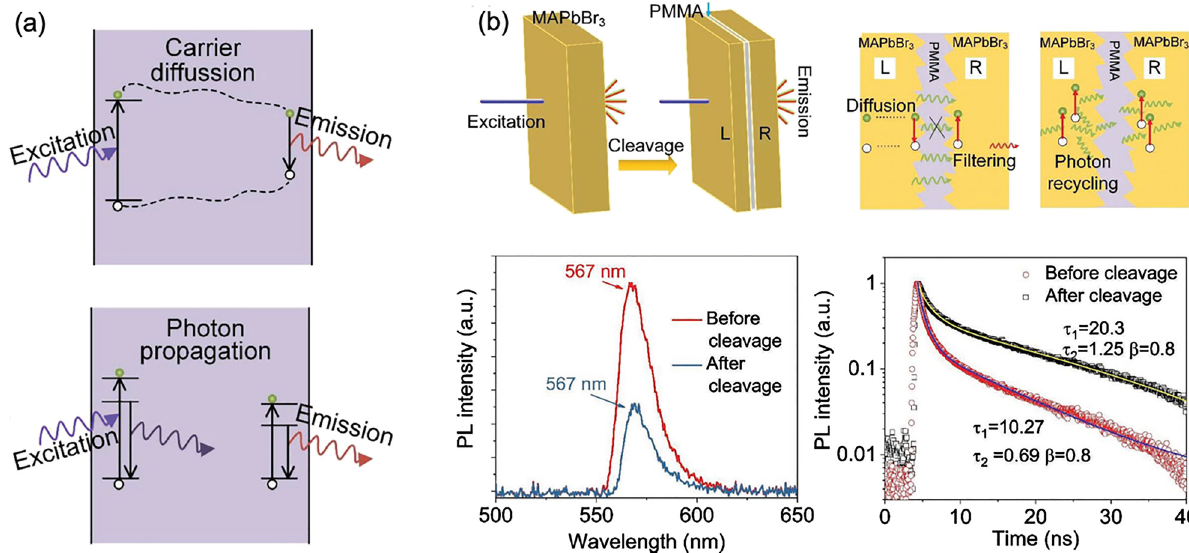
Figure 9: (a) Schematic representing photon recycling and carrier recycling as plausible pathways for long-range carrier dynamics in halide perovskites as discussed by Gan et al. [79], and (b) Schematic, illustrating the cleavage of MAPbBr 3 single crystals with PMMA interfaces for comparing carrier diffusion and photon recycling processes at the interfaces. PL and TRPL images of 3D MAPbBr 3 crystals before and after cleavage indicate photon recycling ’ s central role in single crystals. Figure (a) – (b) are taken with permission from Ref.